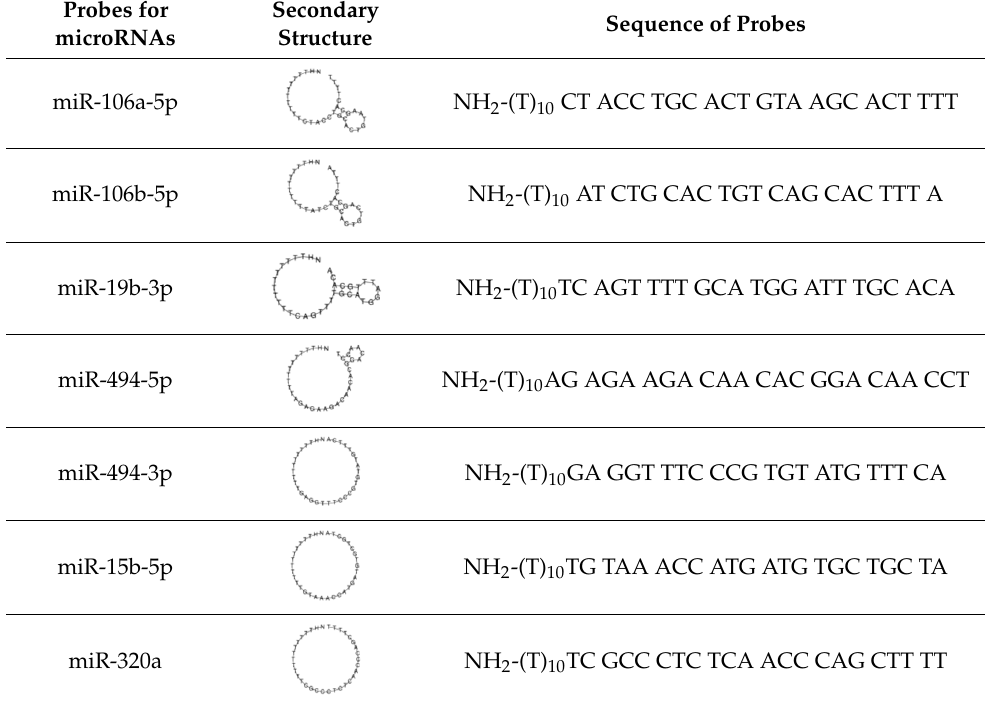
Table 1. Sequences of specific target seven microRNA probes. Probes for mi-